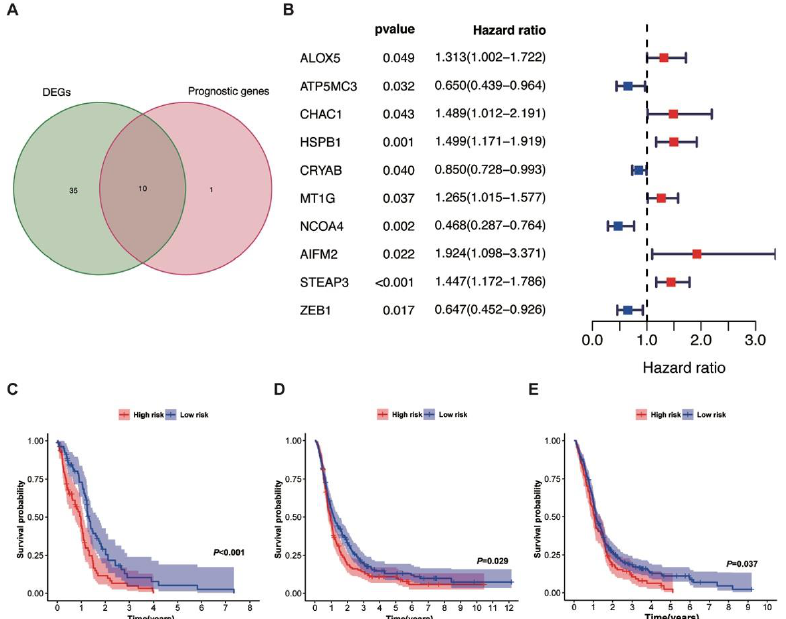
Figure 2. Ferroptosis-related prognostic DEGs and risk stratification based on them. ( A ) Venn diagram of ferroptosis-related DEGs and prognostic genes. ( B ) Univariate Cox regression analyses and forest plot of correlations between ferroptosis-related prognostic DEGs and GBM patients’ survival rates. ( C – E ) Kaplan–Meier curve of difference in survival showed patients in the low-risk group had a statistically significantly better prognosis than patients in the high-risk group in both the training cohort (TCGA) ( C ) and validation cohorts (CGGA ( D ) and GEO ( E )). Red: high-risk group; blue: low-risk group; blue and red square: 95% confidence intervals (CIs).